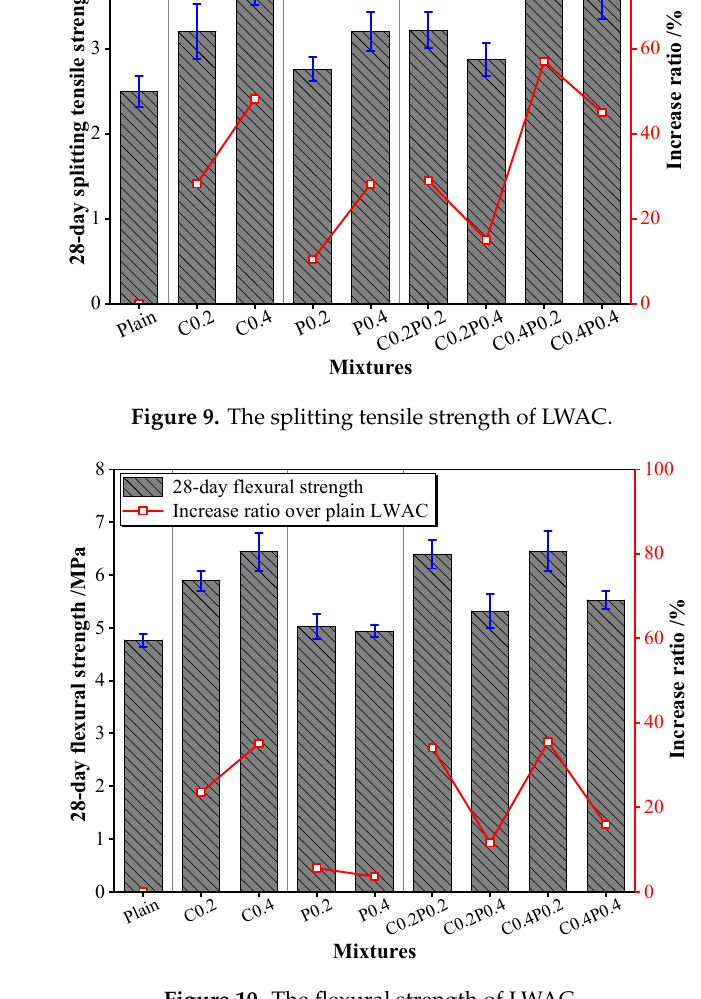
Figure 10. The flexural strength of LWAC.